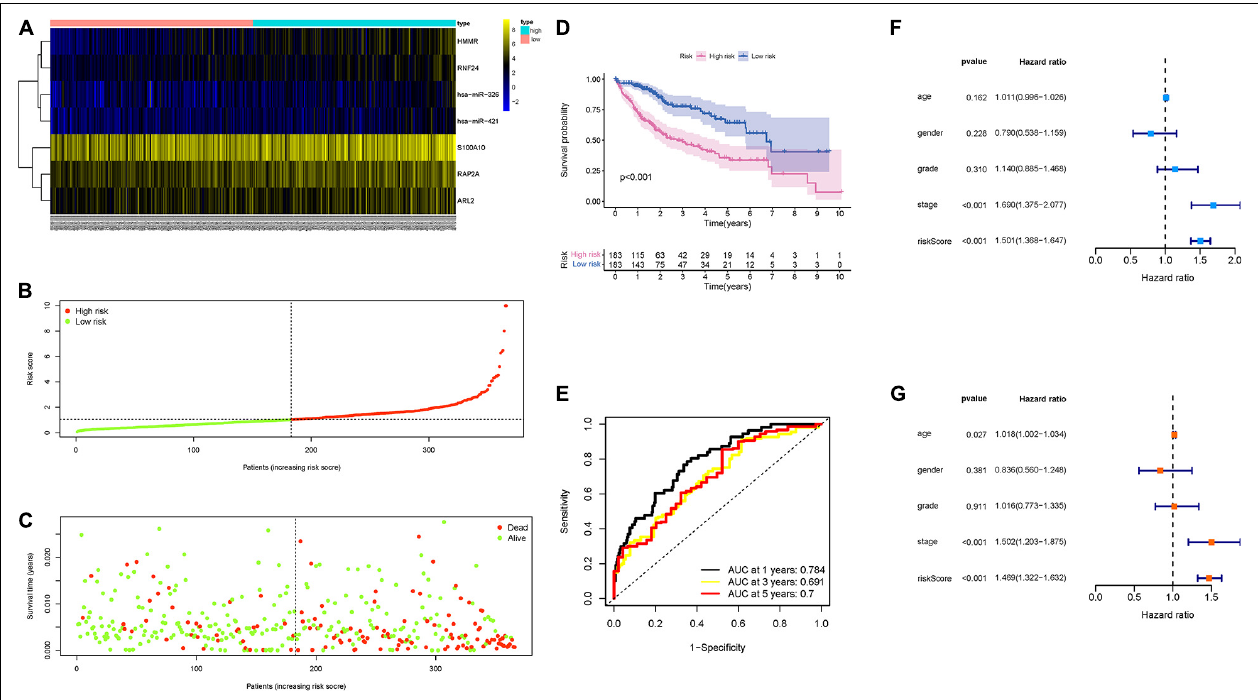
FIGURE 4 | Validation of the prognostic value of risk signature. (A) Heatmap presents the expression pattern of three hub genes in each sample, where the colors of yellow to blue represented alterations from high expression to low expression. (B) Distribution of multigene signature risk score. (C) The survival status and interval of HCC patients. (D) K-M curve analysis presenting difference of OS between the high-risk and low-risk groups. (E) Areas under the curve (AUCs) of the risk scores for predicting 1–, 2–, and 3-year OS time. (F) Univariate Cox regression analyses of OS. (G) Multivariate Cox regression analyses of OS.